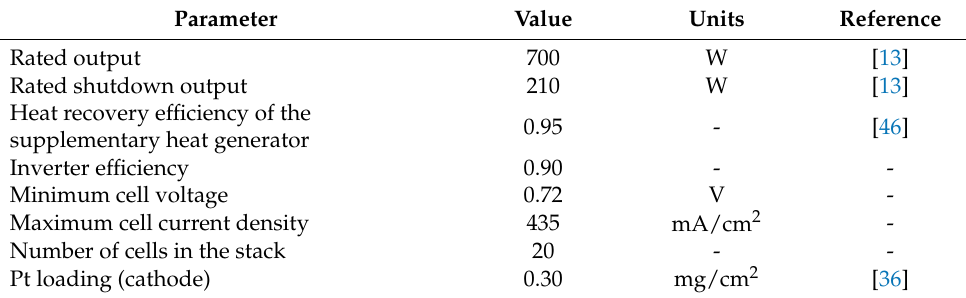
Table 3. The specifications of the PEMFC-CGS and the stack. Parameter Value